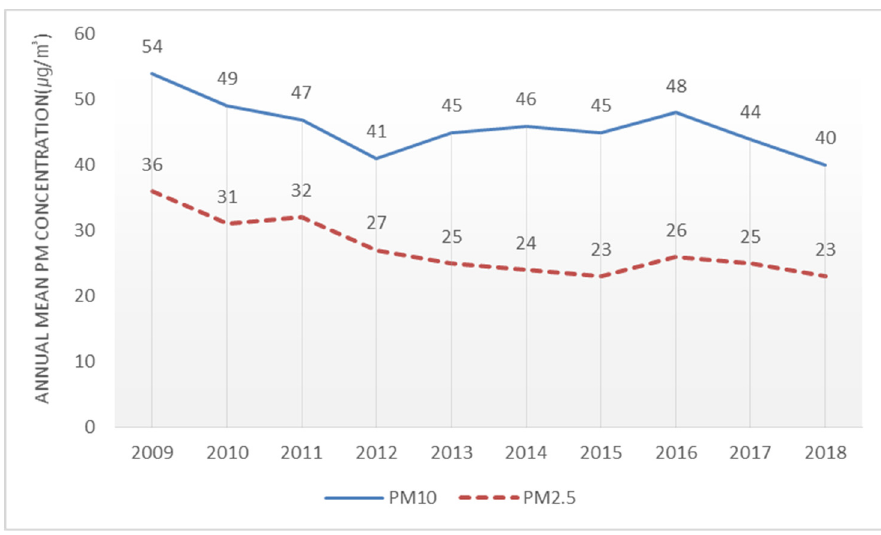
Figure 1. Annual mean particulate matter (PM) concentration in Seoul (2009–2018).